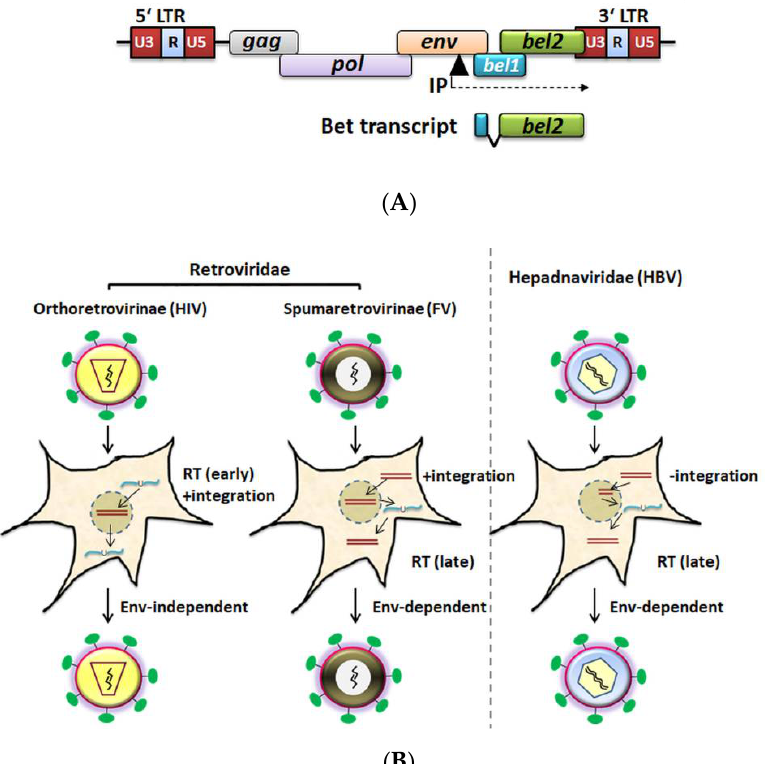
Figure 1. Genome organization of foamy viruses (FV) and schematic representation of replication strategies of animal viruses using reverse transcription (RT). ( A ) FV possesses gag, pol, and env genes. Additional regulatory and accessory bel1 and bel2 genes are localized between env and the 3′LTR. The Bet protein is a product of a spliced transcript and consists of Bel1 (also known as Tas) and Bel2 (alternatively called ORF2) parts. Bel1 and bel2 transcripts are originating from the internal promoter (IP) element, which is indicated as a black triangle, and the direction of transcription is marked with a dashed arrow (figure modified from [89]). ( B ) Replication cycle: Orthoretroviruses (RNA genome in the virion) such as HIV-1 replicate through a dsDNA intermediate and require integration of viral genome into host genome for propagation. Hepadnaviruses (dsDNA in the virion) instead do not integrate their genome but require an RNA intermediate (late RT) for their replication. FVs integrate their genome (DNA) into the host chromosomal DNA like orthoretroviruses, but undergo late reverse transcription like hepadnaviruses. It is controversially discussed in the literature that FV virus particles encapsidate genomic viral RNA or already reverse-transcribed DNA, and the exact copy numbers of both viral genomic RNA and DNA in “cell-free” FV particles remains to be determined in vivo [14,67,82,86,87,90]. The release of FV viral particles depends on the FV glycoprotein [91] as in hepadnaviruses, while budding of orthoretroviral particles is Env-independent. RT, reverse transcriptase, RNA and DNA molecules are denoted by blue lines with U and brown lines respectively. Arrows in the figure indicate the path of the viral replication event. (Figure adapted from [63] and taken from one author’s thesis [92]). Hepadnaviruses are depicted here to illustrate different viral replication strategies of animal viruses with a reverse transcription step.